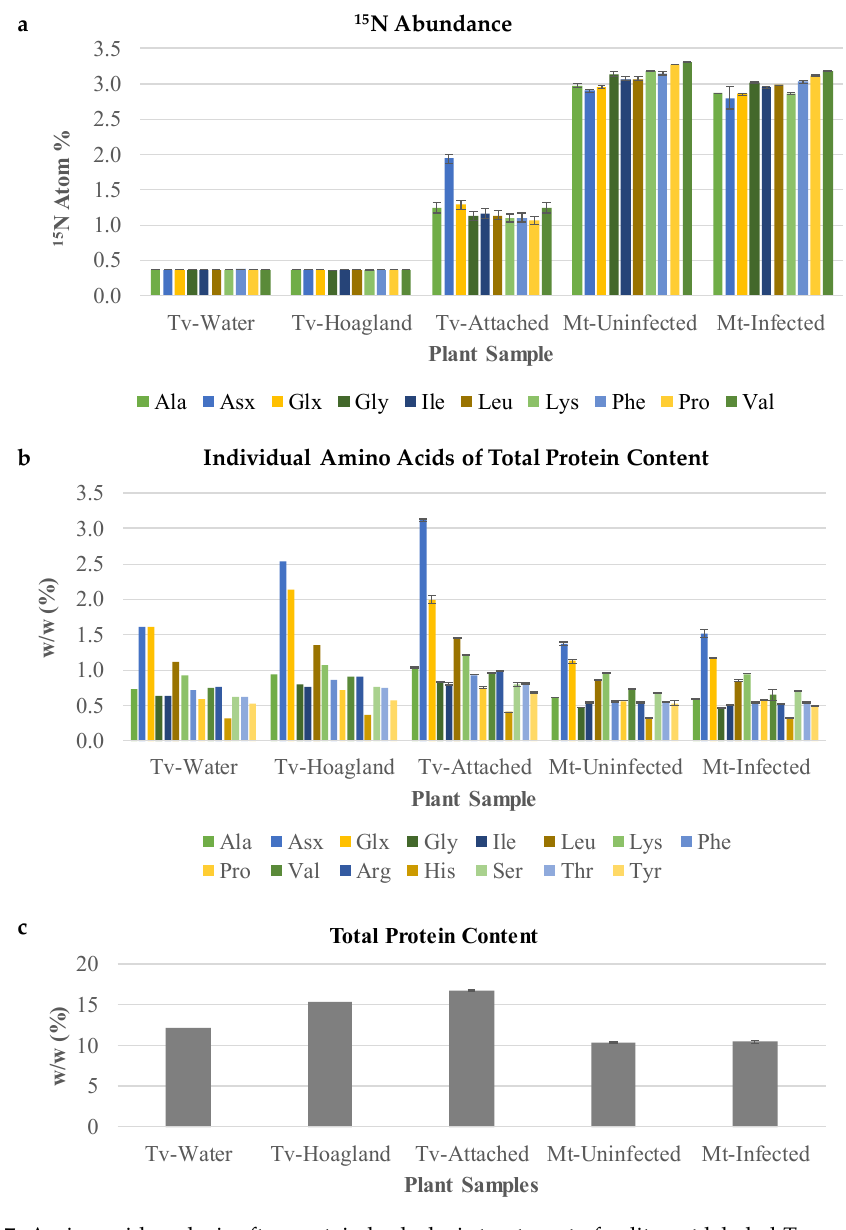
Figure 7. Amino acid analysis after protein hydrolysis treatment of split-root labeled T. versicolor . ( a ) An 15 N abundance analysis of amino acids of samples collected from the split root system. Tv-Water and Tv-Hoagland’s represent parasites grown in the absence of host roots and 15 N nitrate. As such, their amino acids are labeled to the level of 15N natural abundance, which is about 0.4. ( b ) Individual amino acids of total proteins content of the same samples used in 15 N abundance analysis. ( c ) Total protein content, representing the sum of the individual amino acid contents. Mt-Uninfected, roots of M. truncatula growing in rhizotron B without T. versicolor . Mt-Infected, roots of M. truncatula growing in rhizotron B that had T. versicolor attached for 12 days of co-culture. Tv-Water, T. versicolor growing in a rhizotron on their own with H 2 O. Tv-Hoagland’s, T. versicolor growing in a rhizotron on their own with × Hoagland’s media. Tv-Attached, T. versicolor growing in rhizotron B collected after attachment 1 4